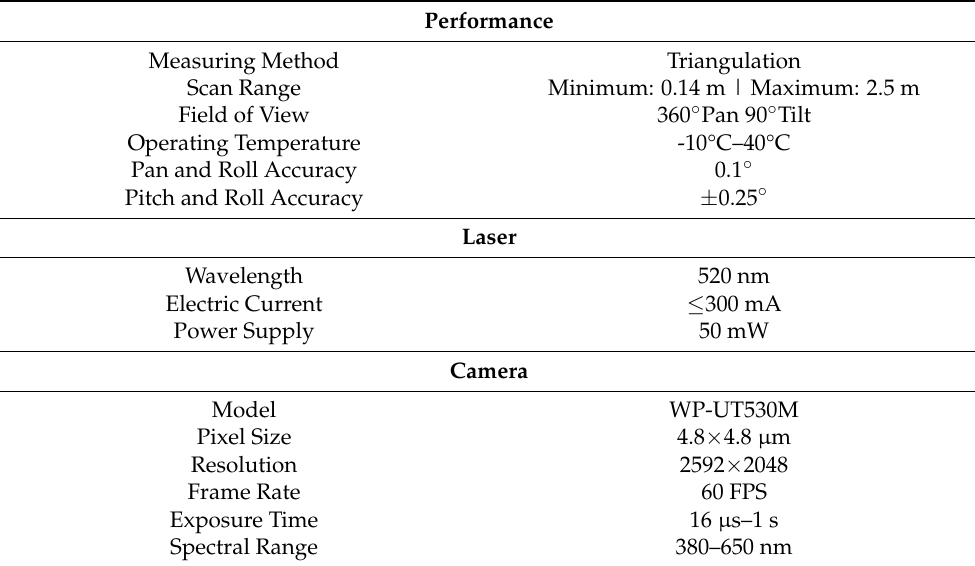
Table 2. Mechanical model of rotary scanning